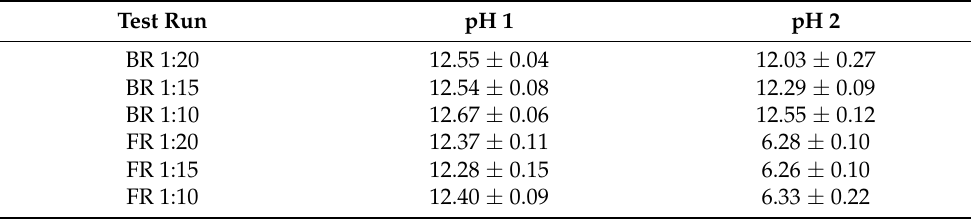
Table 4. pH values for each test run presented with mean values ± standard deviations (SD) for the batch run (BR) and for the flow run (FR); the ratios of 1:20, 1:15 and 1:10 describe the mixing ratios of water and ash for the test runs; pH 1 (prior carbonation), pH 2 (after